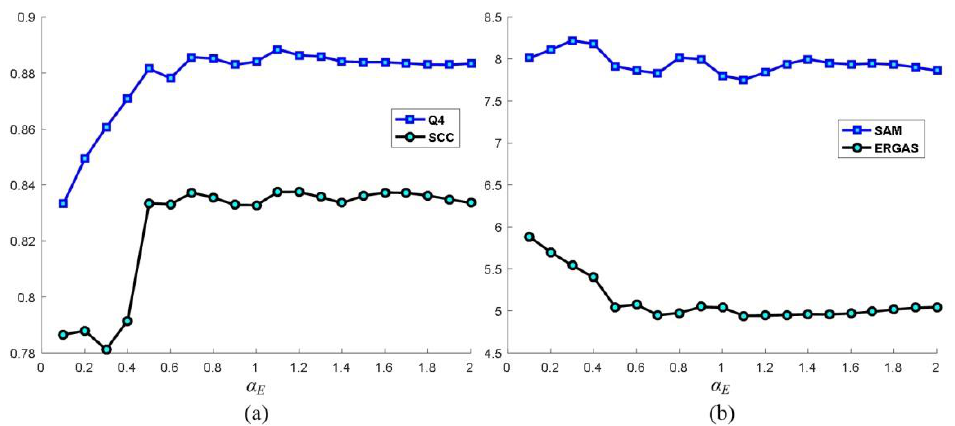
Figure 9. Analysis of the parameters α E . ( a ) Q4 and SCC. ( b ) SAM and ERGAS.